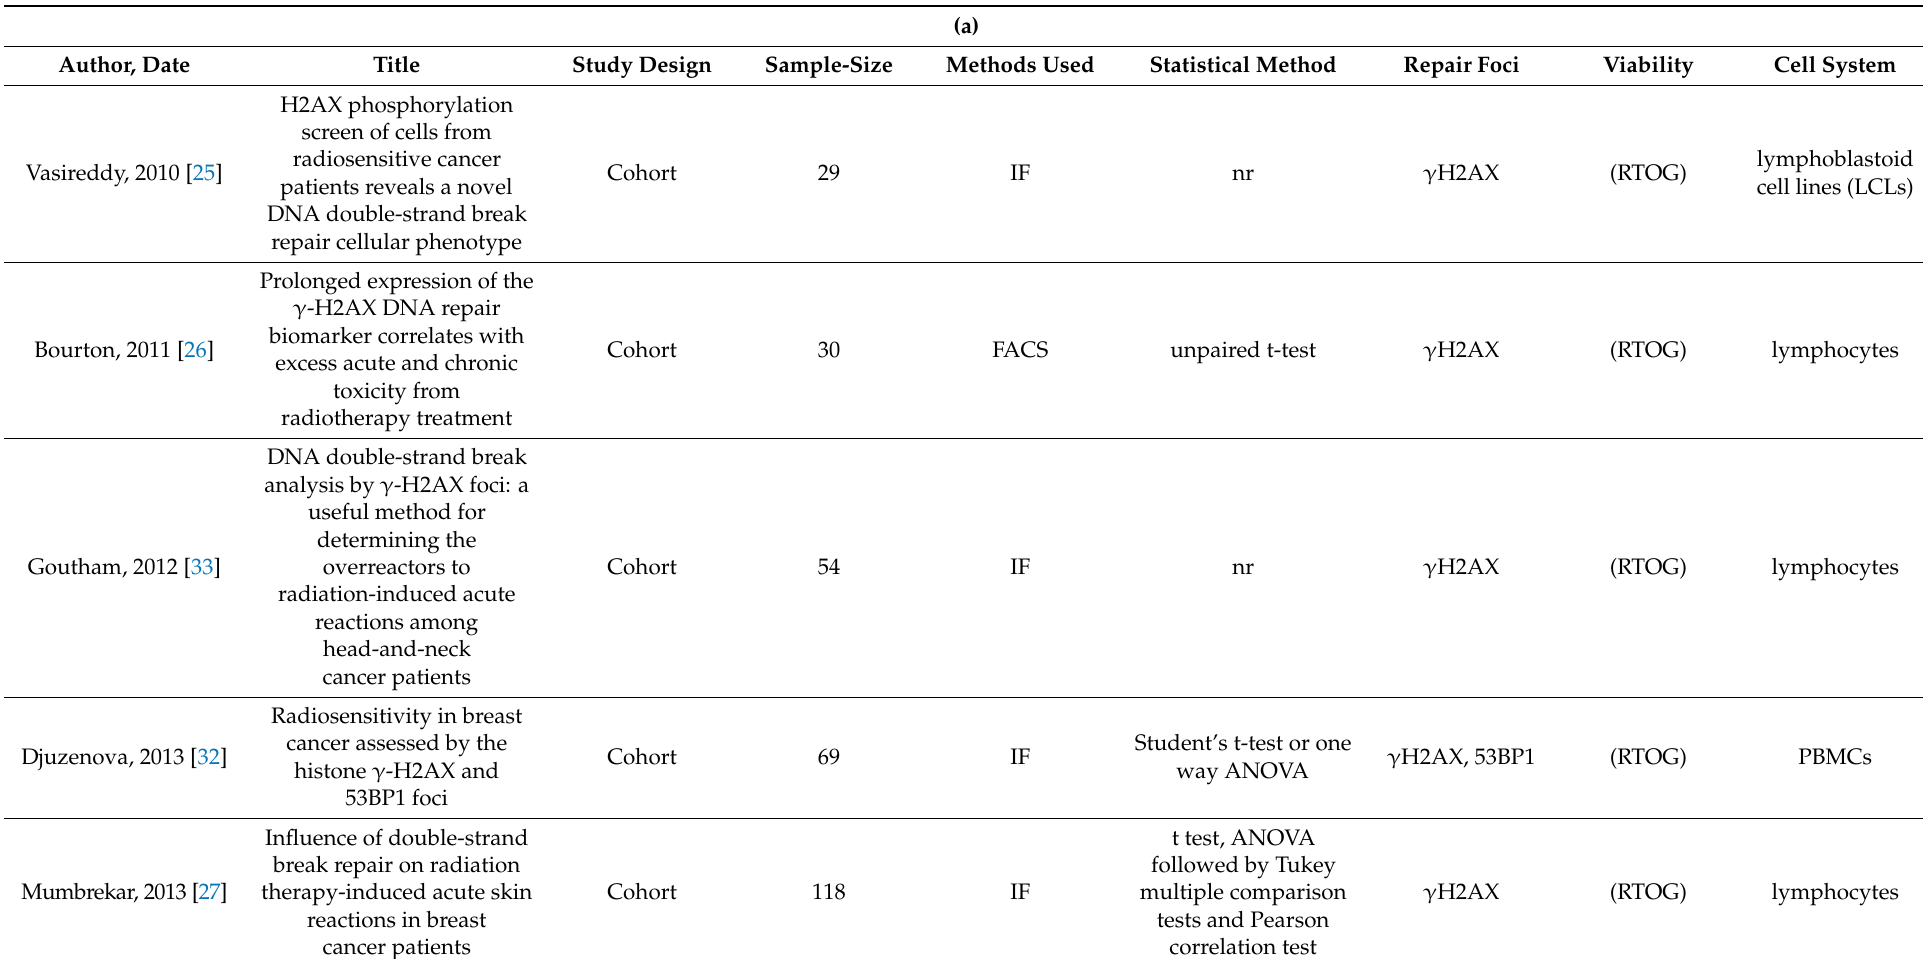
Table 1. (a) Study characteristics of included records concerning repair foci. (b) Study characteristics of included records containing proteins other than repair foci.